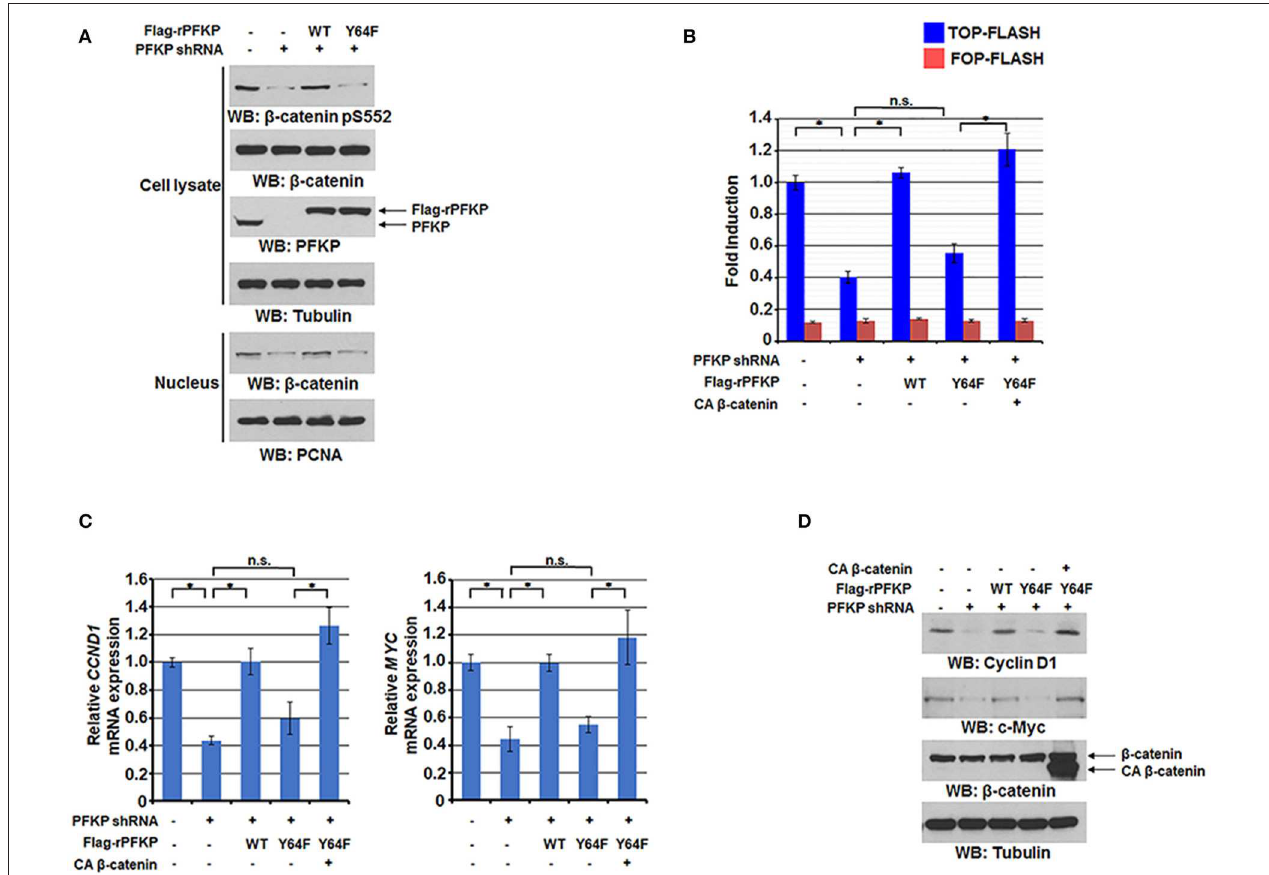
FIGURE 2 | PFKP Y64 phosphorylation by EGFR enhances AKT-mediated β -catenin S552 phosphorylation and nuclear translocation of β -catenin and expression of its downstream genes. (A) Nuclear fractions of U87/EGFRvIII cells with or without PFKP depletion and with or without reconstituted expression of WT Flag-rPFKP